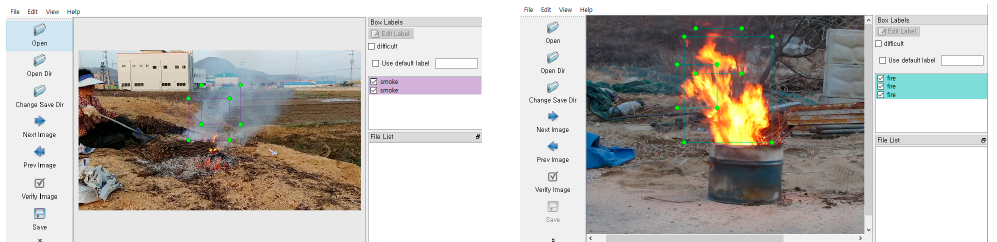
Figure 3. Example of labeling area for fire and smoke dataset image.